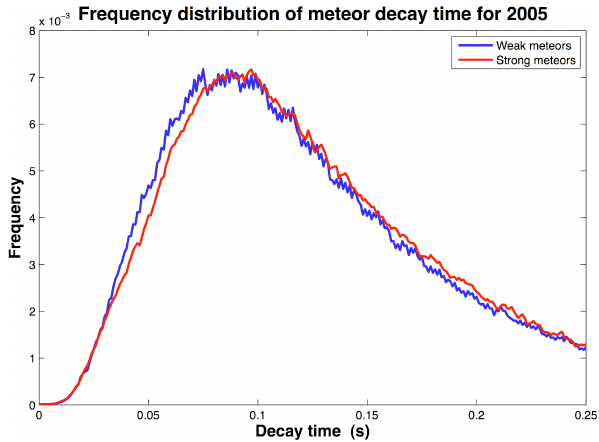
Fig. 3. Frequency distributions of meteor decay times for 2005. The distribution of weak meteors (SNR < 12dB) is shown in blue; strong meteors (SNR ≥ 12dB) in